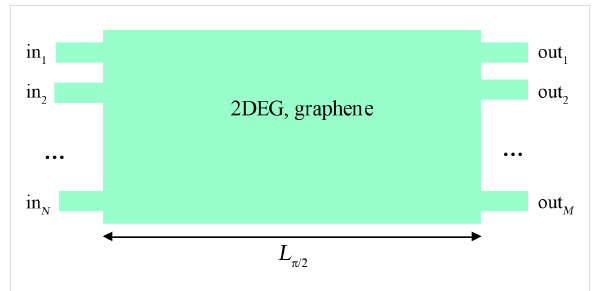
Figure 3: Schematic representation of a configuration that implements a discrete Fourier transform by discretizing the input and output chan- nels of the